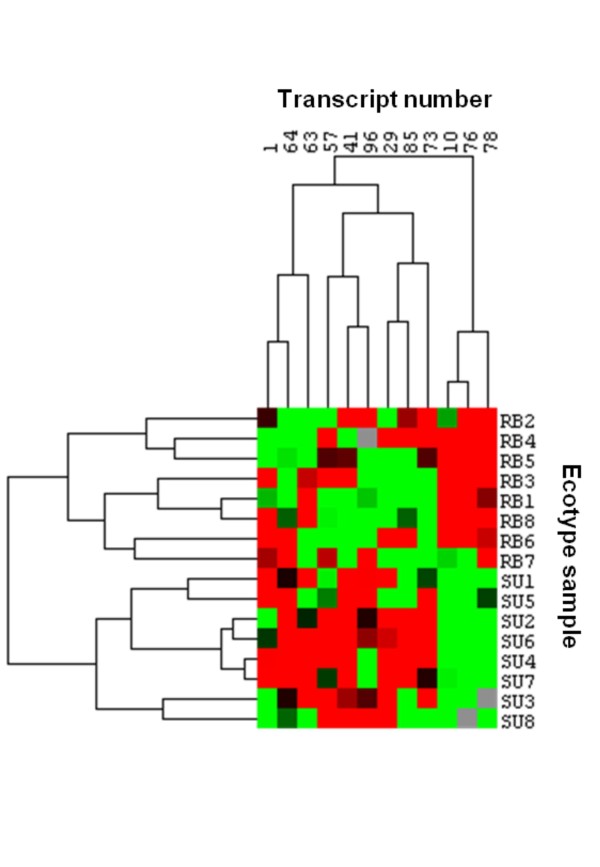
Hierarchical clustering of the transcripts based on their expression profiles (using the averaged values from the technical replicates). Rows represent the pools of individuals from each ecotype and columns represent the transcripts. Red indicates enhanced expression while green reflects decreased expression. All individuals were correctly clustered by their ecotype.